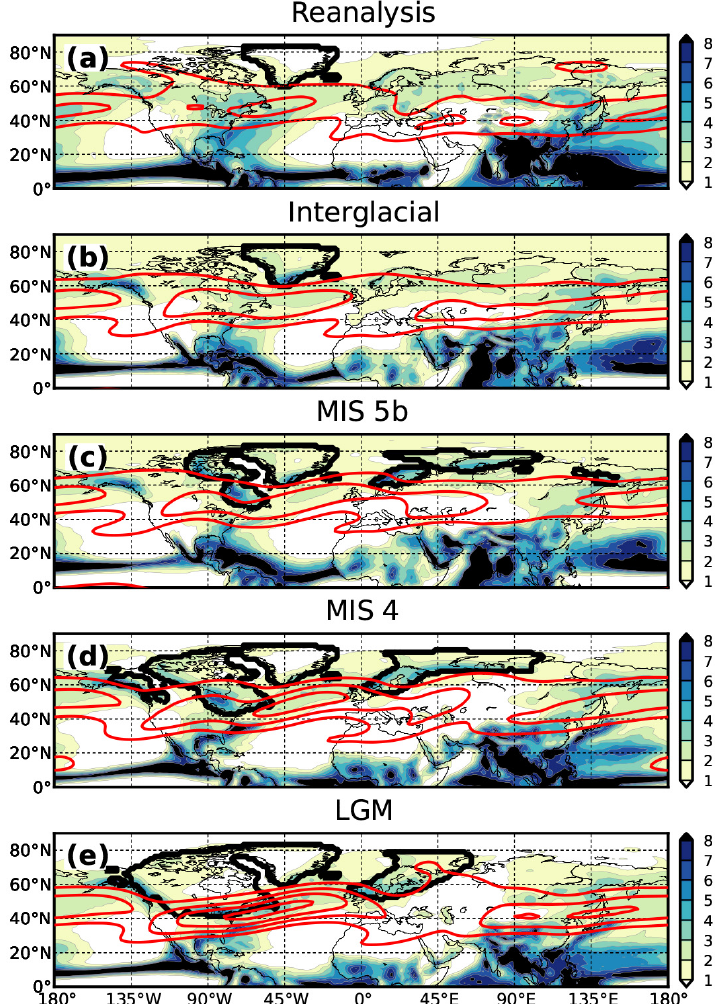
Figure 6. Evolution of the winter (JJA) precipitation (mmday − 1 ) over the glacial cycle. The ice sheets are indicated by the heavy black contours and the red contour lines show the 300hPa zonal wind speed (10ms − 1 contours starting at 10ms − 1